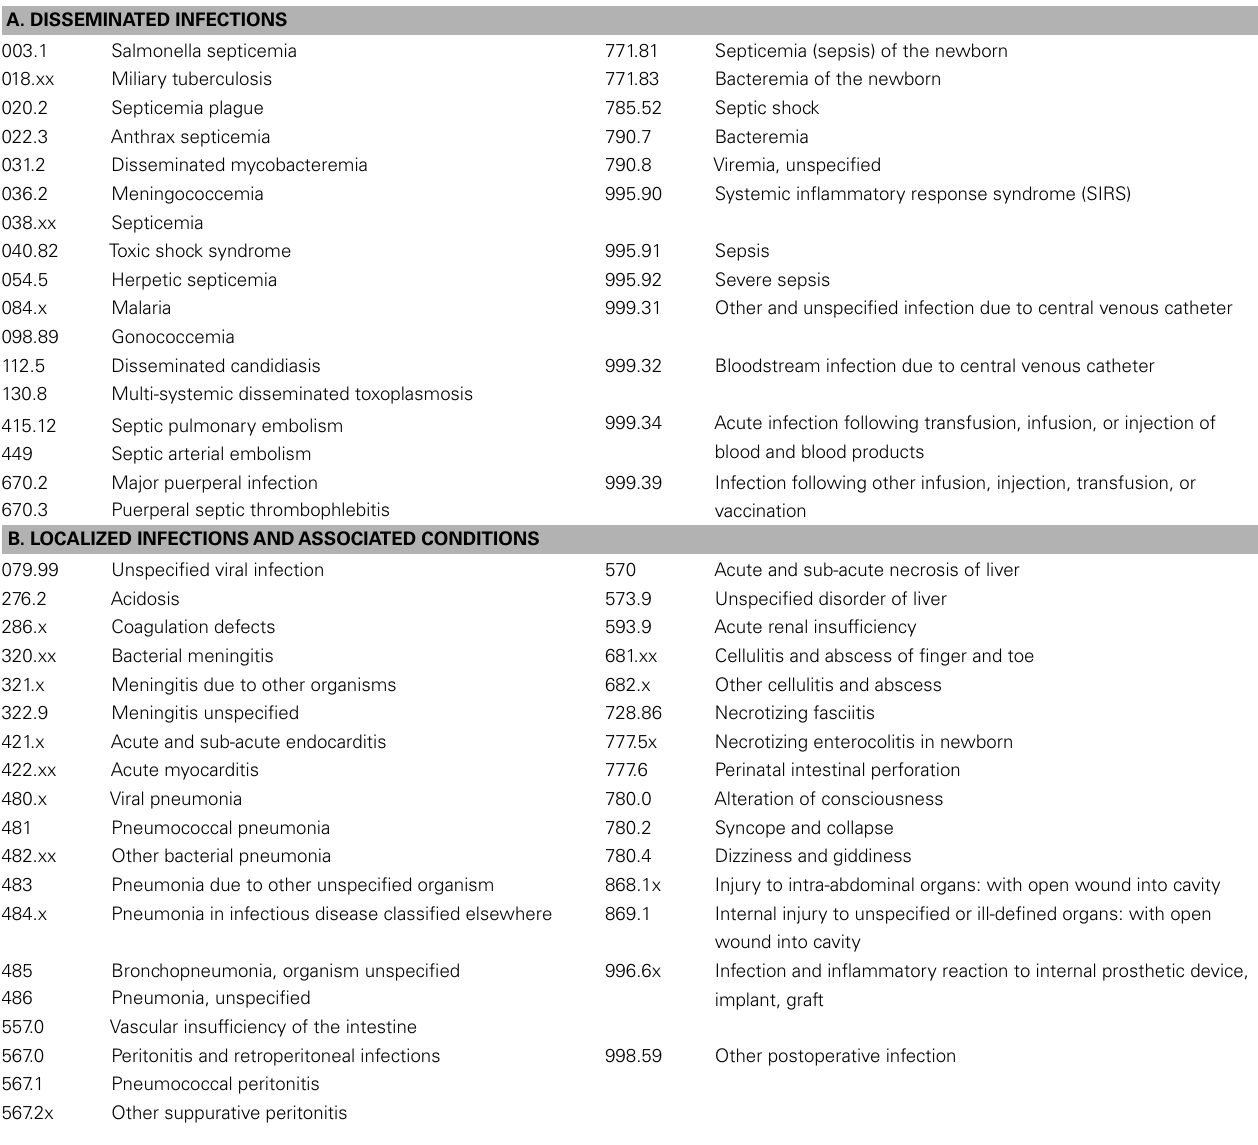
Table 1 | List of ICD-9-CM (21) coded diagnoses selected for chart review